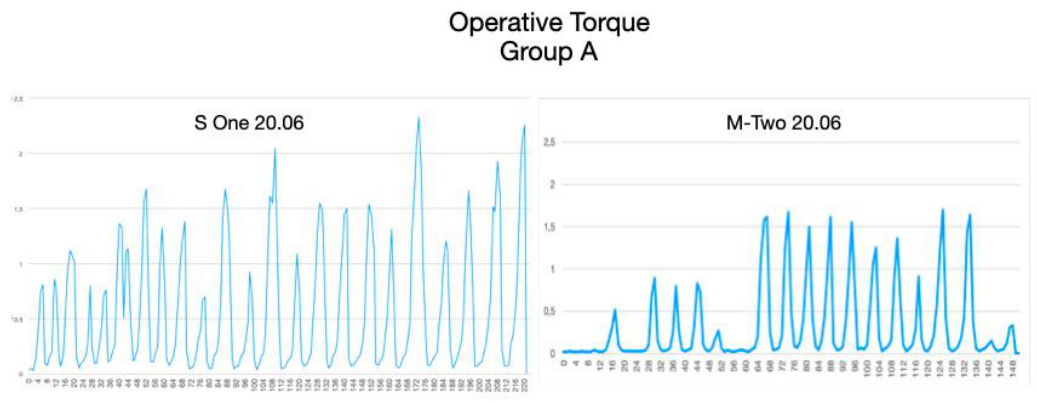
Figure 1. Operative torque for group A.